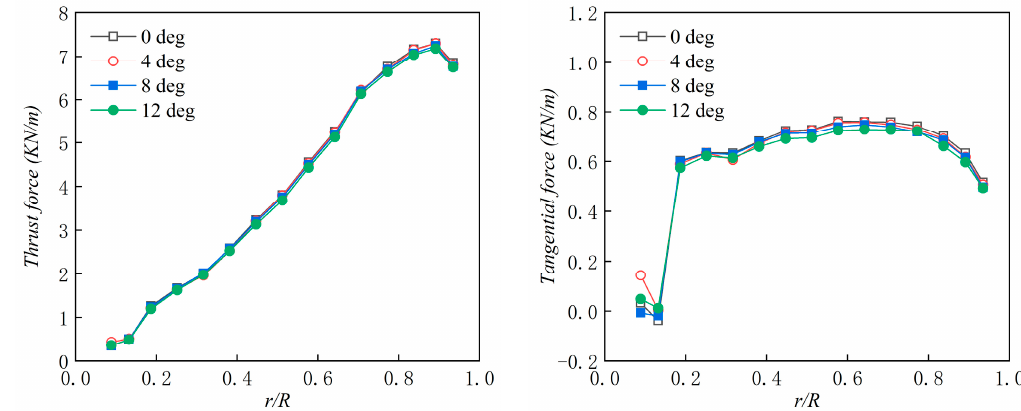
Figure 15. The average thrust and average tangential force per unit of span along the blade span for Blade 1.